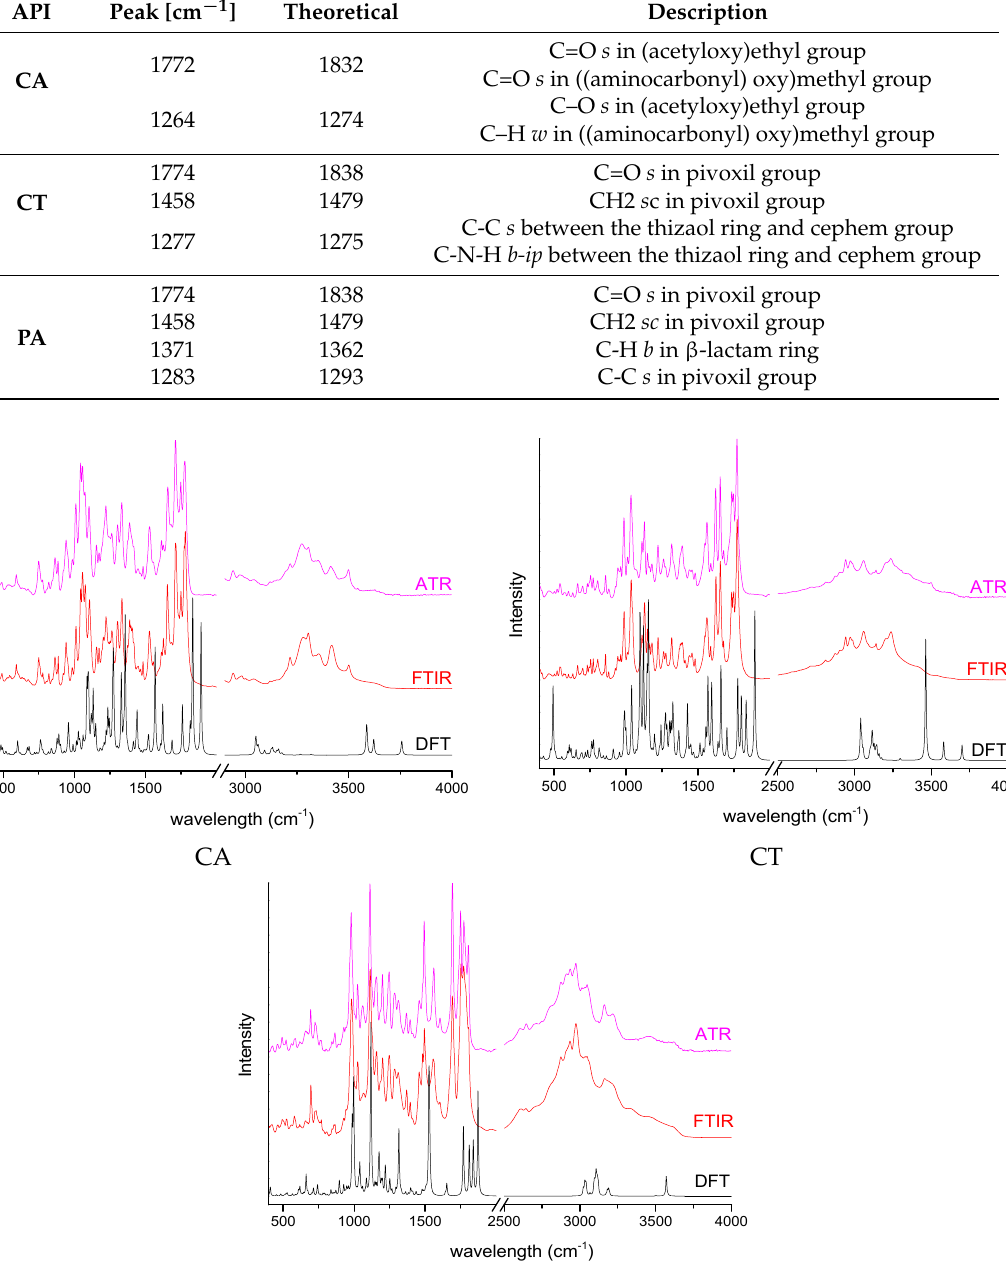
Table 4. The spectral bands contributing to model, most important features first.